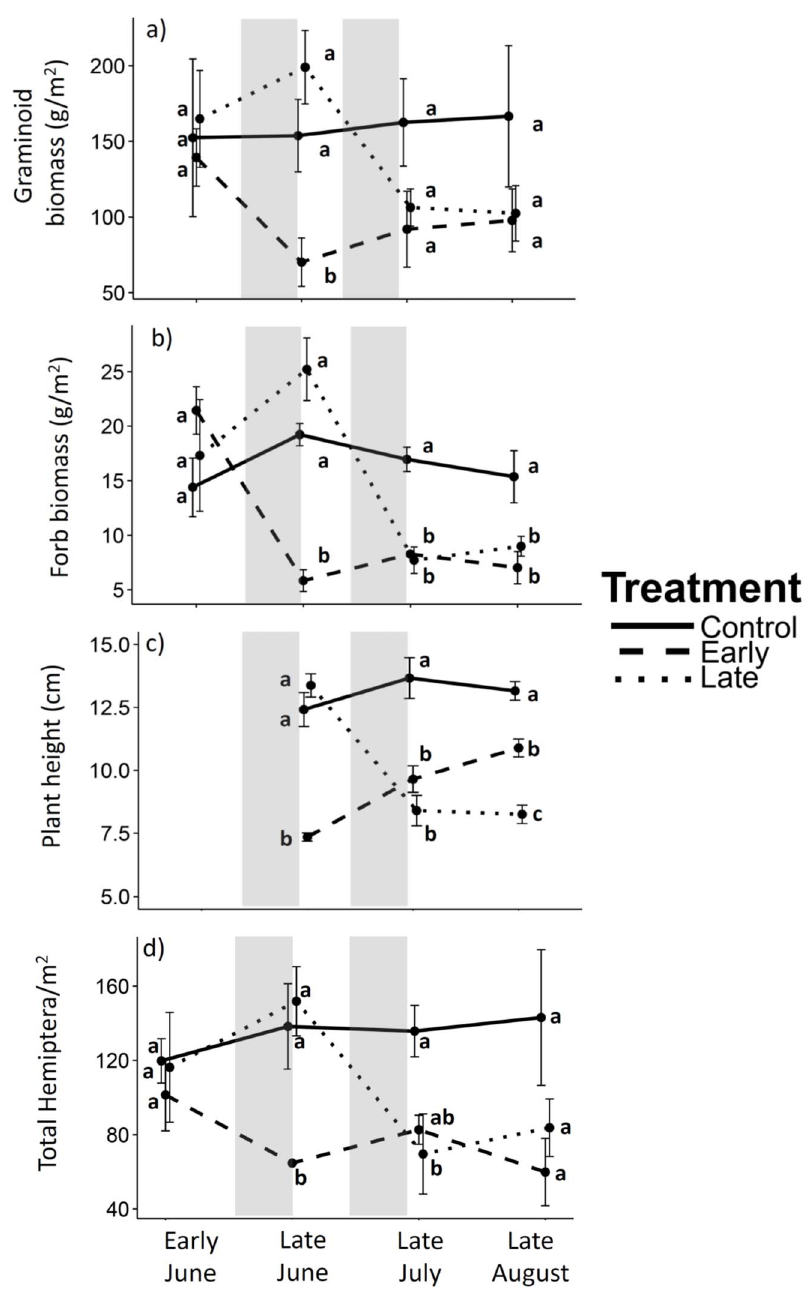
Figure 3. Temporal effects of grazing treatments on plant and arthropod variables for the upland grassland. Values for a) graminoid biomass, b) forb biomass, c) plant height (not sampled in early June), and d) Hemiptera density are untransformed means 6 1 SE. Duration of early and late grazing treatments are shown by shaded grey boxes. Significant treatment differences within a sampling event are indicated by differing letters. Tukey’s HSD results for significant sampling event differences within a treatment are shown in Table 3.